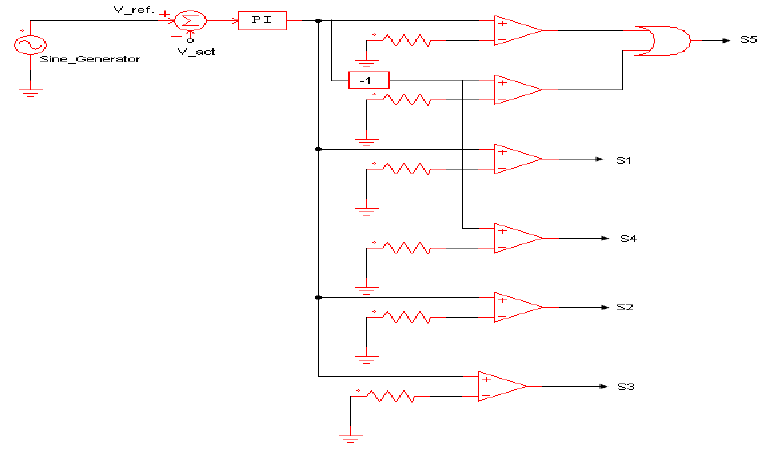
Figure 20. Control circuit of a five-level